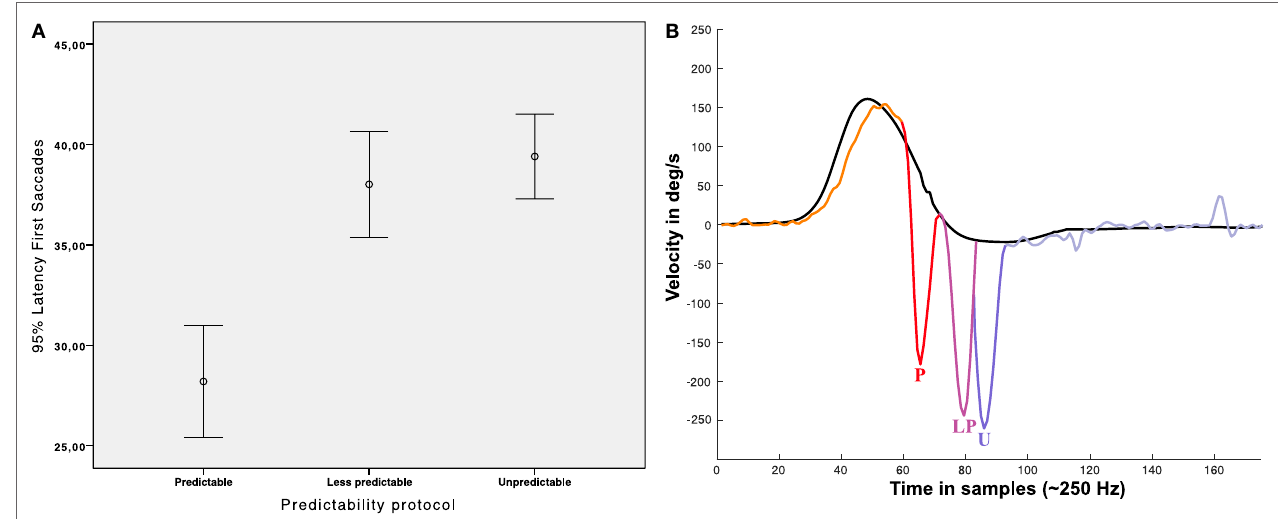
FigUre 7 | Latency of first saccades. (a) Error Bar’s graph representing the latency of the first saccadic response obtained in our population depending on the protocol performed. (B) Infographic plot showing nearest to mean measured first saccades latency for each protocol; P: (mean) early saccade obtained with predictable protocol (~112 ms), LP: (mean) Not early saccade obtained with less predictable protocol (~154 ms), U: not early saccade obtained with unpredictable protocol (~178 ms), all the mean latencies were statistical significant ( p < 0.05). In (B) , head impulse (black line) and eye responses (multicolor line) are approximated scaled plots obtained from real data